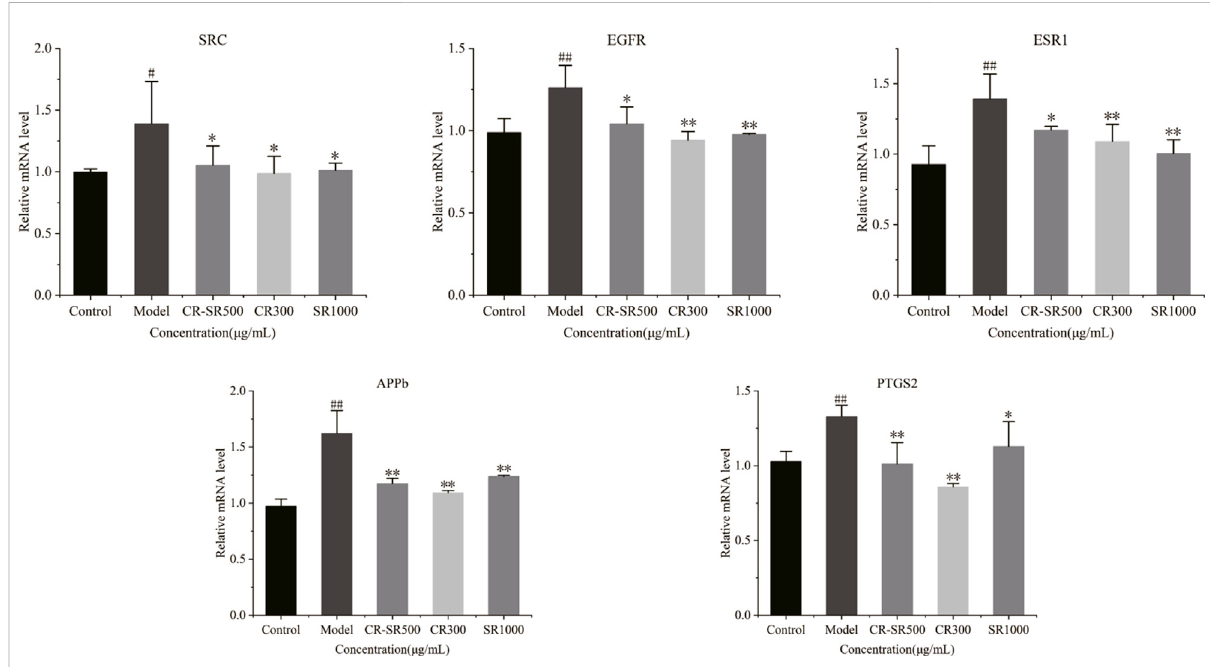
FIGURE 12 Expression of SRC, EGFR, ESR1, PTGS2, and APP in zebra fi sh larvae was detected by